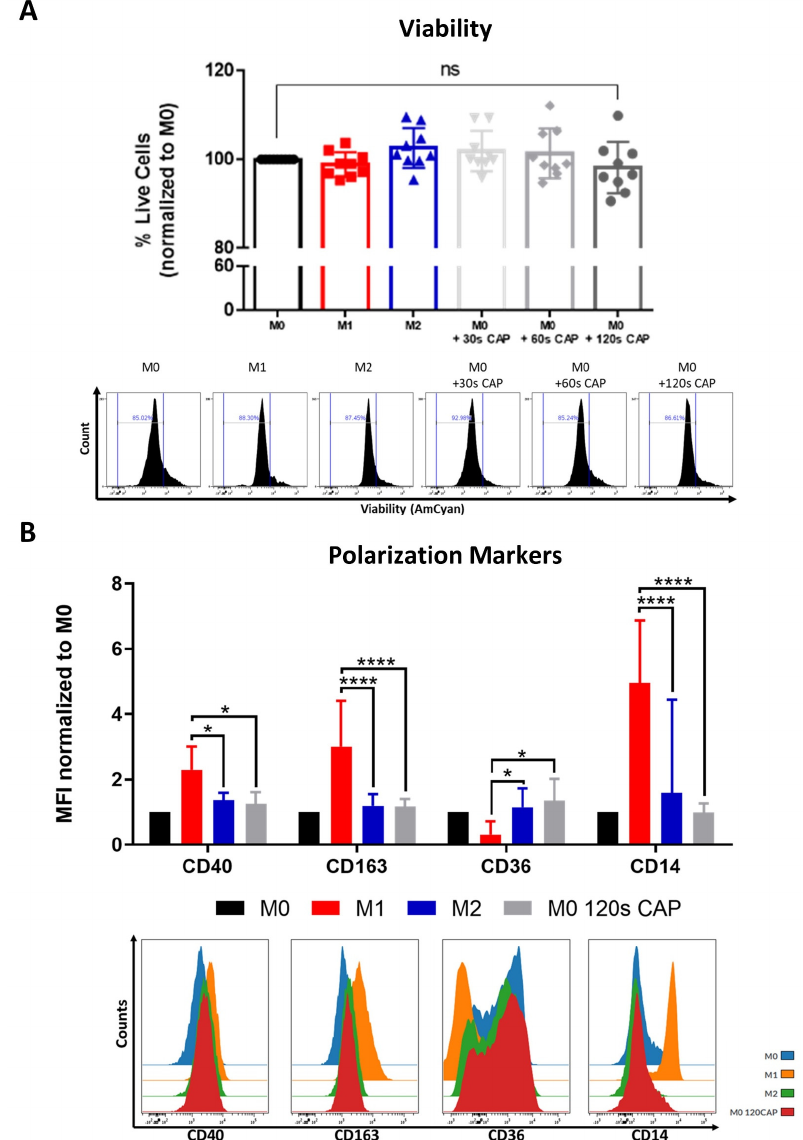
Figure 3. Macrophages are highly resistant to CAP and can be polarized into a “M0/M2-like” phenotype. ( A , B ) M0 macrophages were treated with varying amounts of CAP (30 s, 60 s, 120 s). M1 and M2 polarized macrophages served as a control. After 2 days, cells were analyzed via flow cytometry; ( A ) cells were stained for viability. Bar diagram shows the average percentage of live cells measured ± SD, normalized to untreated M0 macrophages, and represents the pooled results of twelve independent experiments ( n = 12 donors); ( B ) cells were stained with different macrophage polarization markers. Bar diagram shows the average mean fluorescent intensity (MFI) of each measured marker normalized to untreated M0 macrophages and represents the pooled results of twelve independent experiments ( n = 12 donors); histograms paired to bar diagrams show one representative result. Statistical significance was calculated by performing two-way ANOVAs corrected for multiple comparisons with Tukey tests and is indicated by the asterisks as follows: * p < 0.05; **** p <